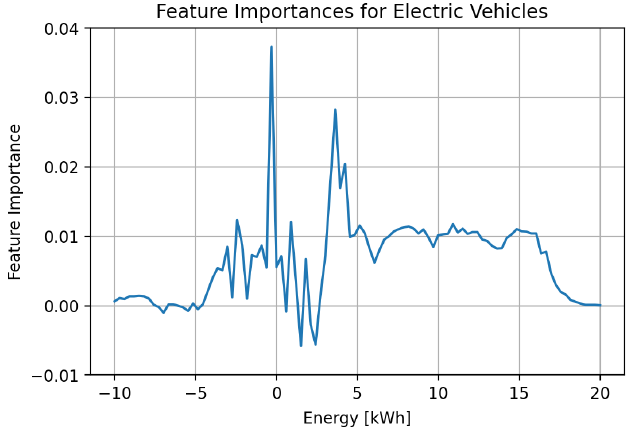
Figure 8. Feature importance of the MLP branch of the Combined Classifier based on the kernel density data of the monthly input time span for detecting electric vehicle charging